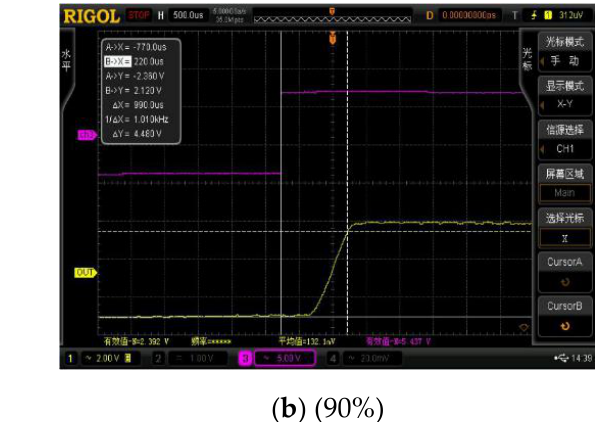
Figure 21. DC leakage time response of the sensor.